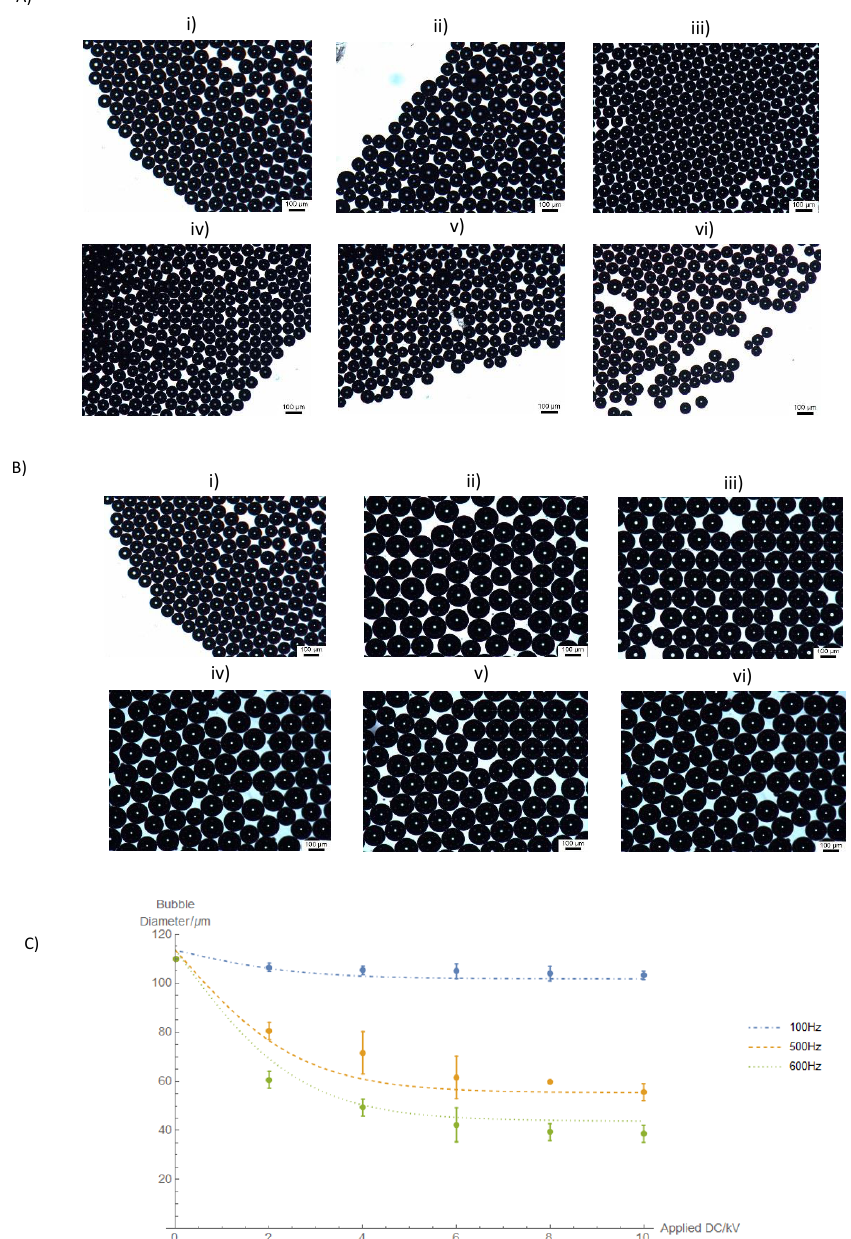
Figure 2. ( A ) Optical micrographs of bubbles obtained at a superimposed AC voltage of 2 kV P–P at DC voltages of ( i ) 0 V, ( ii ) 2 kV, ( iii ) 4 kV, ( iv ) 6 kV, ( v ) 8 kV, and ( vi ) 10 kV. ( B ) Optical micrographs of microbubbles obtained at a superimposed AC voltage of 4 kV P–P at DC voltages of ( i ) 0 kV, ( ii ) 2 kV, ( iii ) 4 kV, ( iv ) 6 kV, ( v ) 8 kV, and ( vi ) 10 kV. ( C ) Variation of microbubble diameter with applied DC voltage at different P–P AC voltages, error bars represent three standard deviations, estimated from repeat experiments. Curves represent a fit to a simple analytic